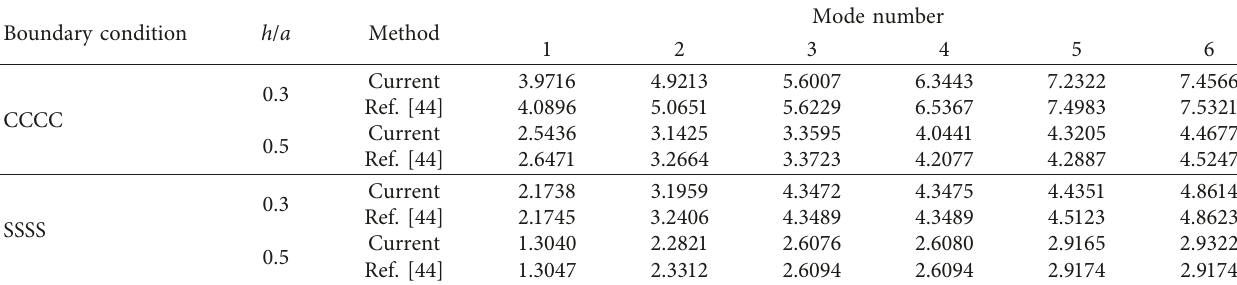
Table 3: Comparison of frequency parameters Ω � ( ω b 2 / π 2 ) conditions.